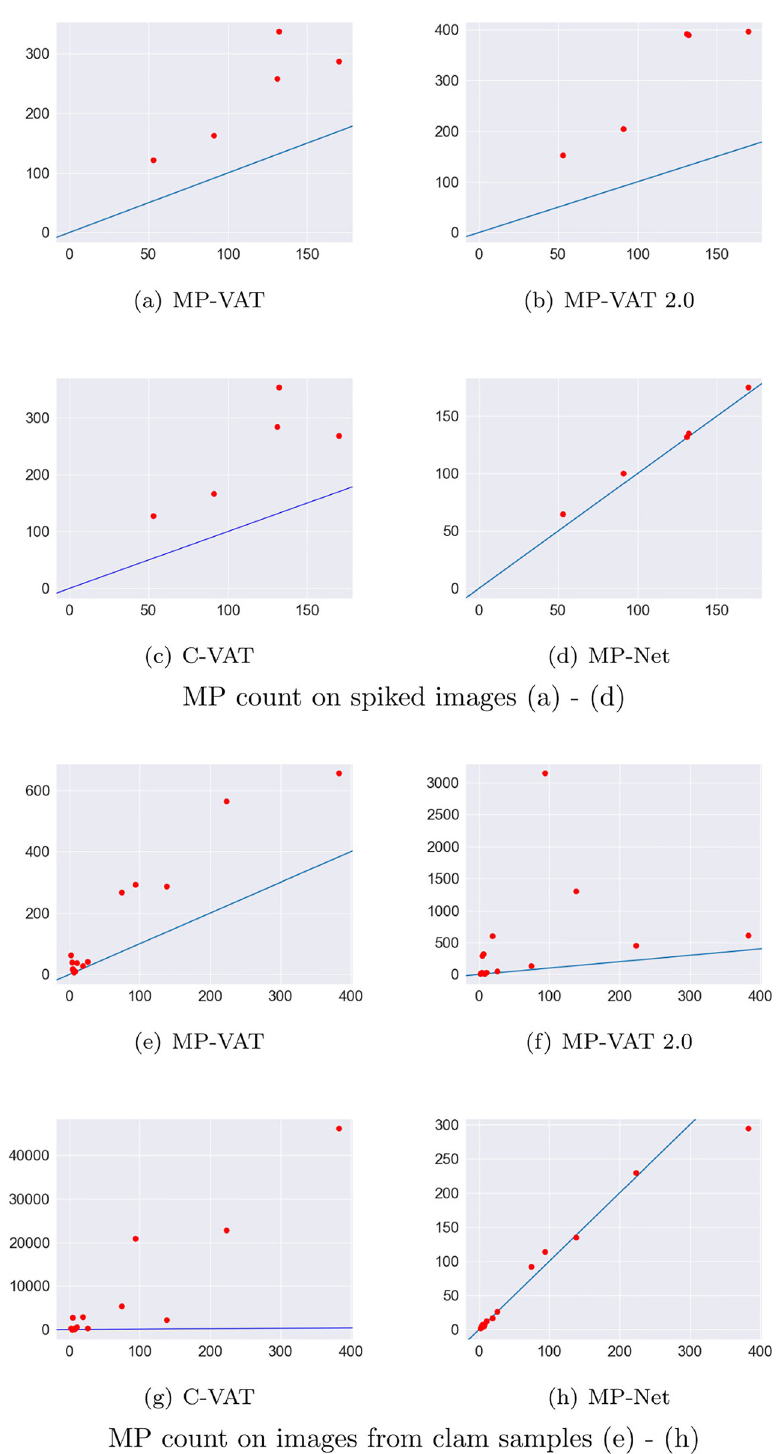
Fig 11. Recovery assessment. Comparison of MP counts obtained for five spiked images (a)—(d) and 15 real images from clam samples (e)—(h). Red dots represent tested images. The x-coordinate refers to the ground truth MP count and the y-coordinate denotes the predicted MP count. For a red dot above the first bisector (blue line), the number of MPs is overestimated by the model (MP-VAT, MP-VAT 2.0, C-VAT and MP-Net). (a) MP-VAT. (b) MP-VAT 2.0. (c) C-VAT. (d) MP-Net. (e) MP-VAT. (f) MP-VAT. (g) C-VAT. (h) MP-Net. MP count on spiked images (a)–(d). MP count on images from clam samples (e)–(h). https://doi.org/10.1371/journal.pone.0269449.g011 PLOS ONE | https://doi.org/10.1371/journal.pone.0269449 June 15,